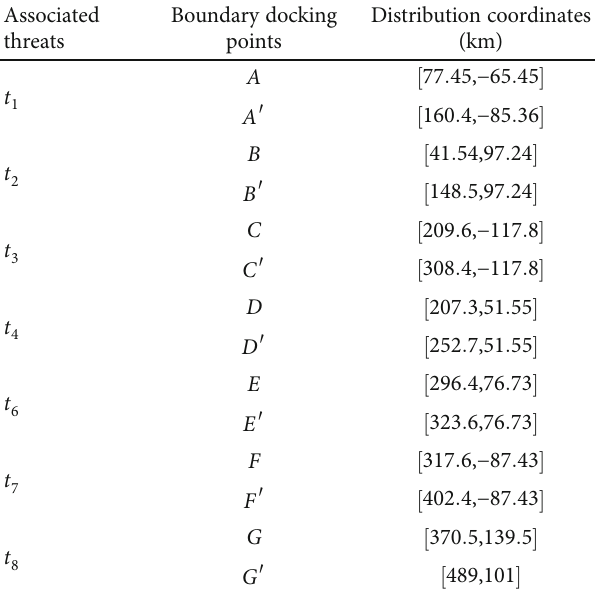
Table 4: Associated convex polygons and threats. Intersection Associated convex points polygons